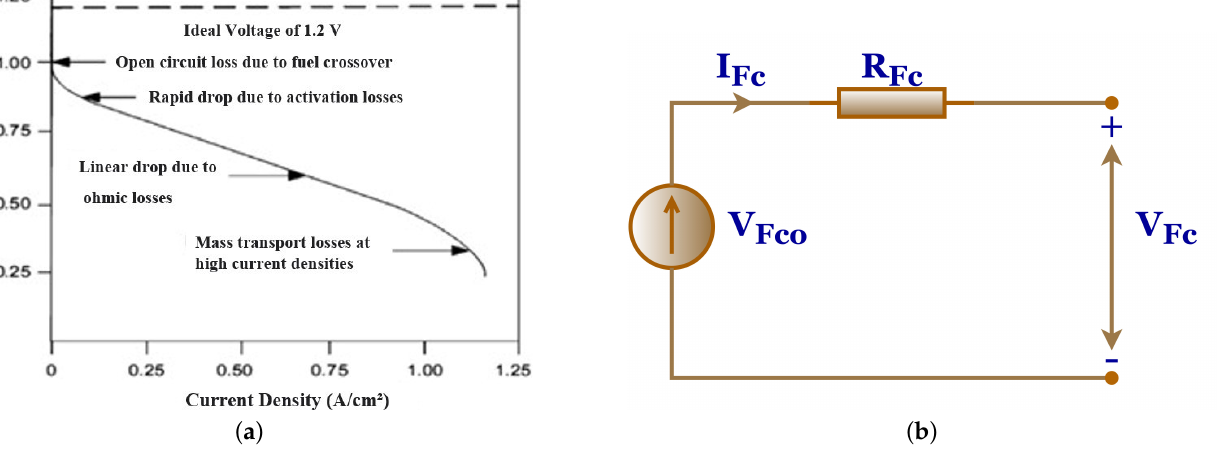
Figure 1. ( a ) V – I characteristic feature and corresponding ( b ) equivalent circuit model of an FC system.